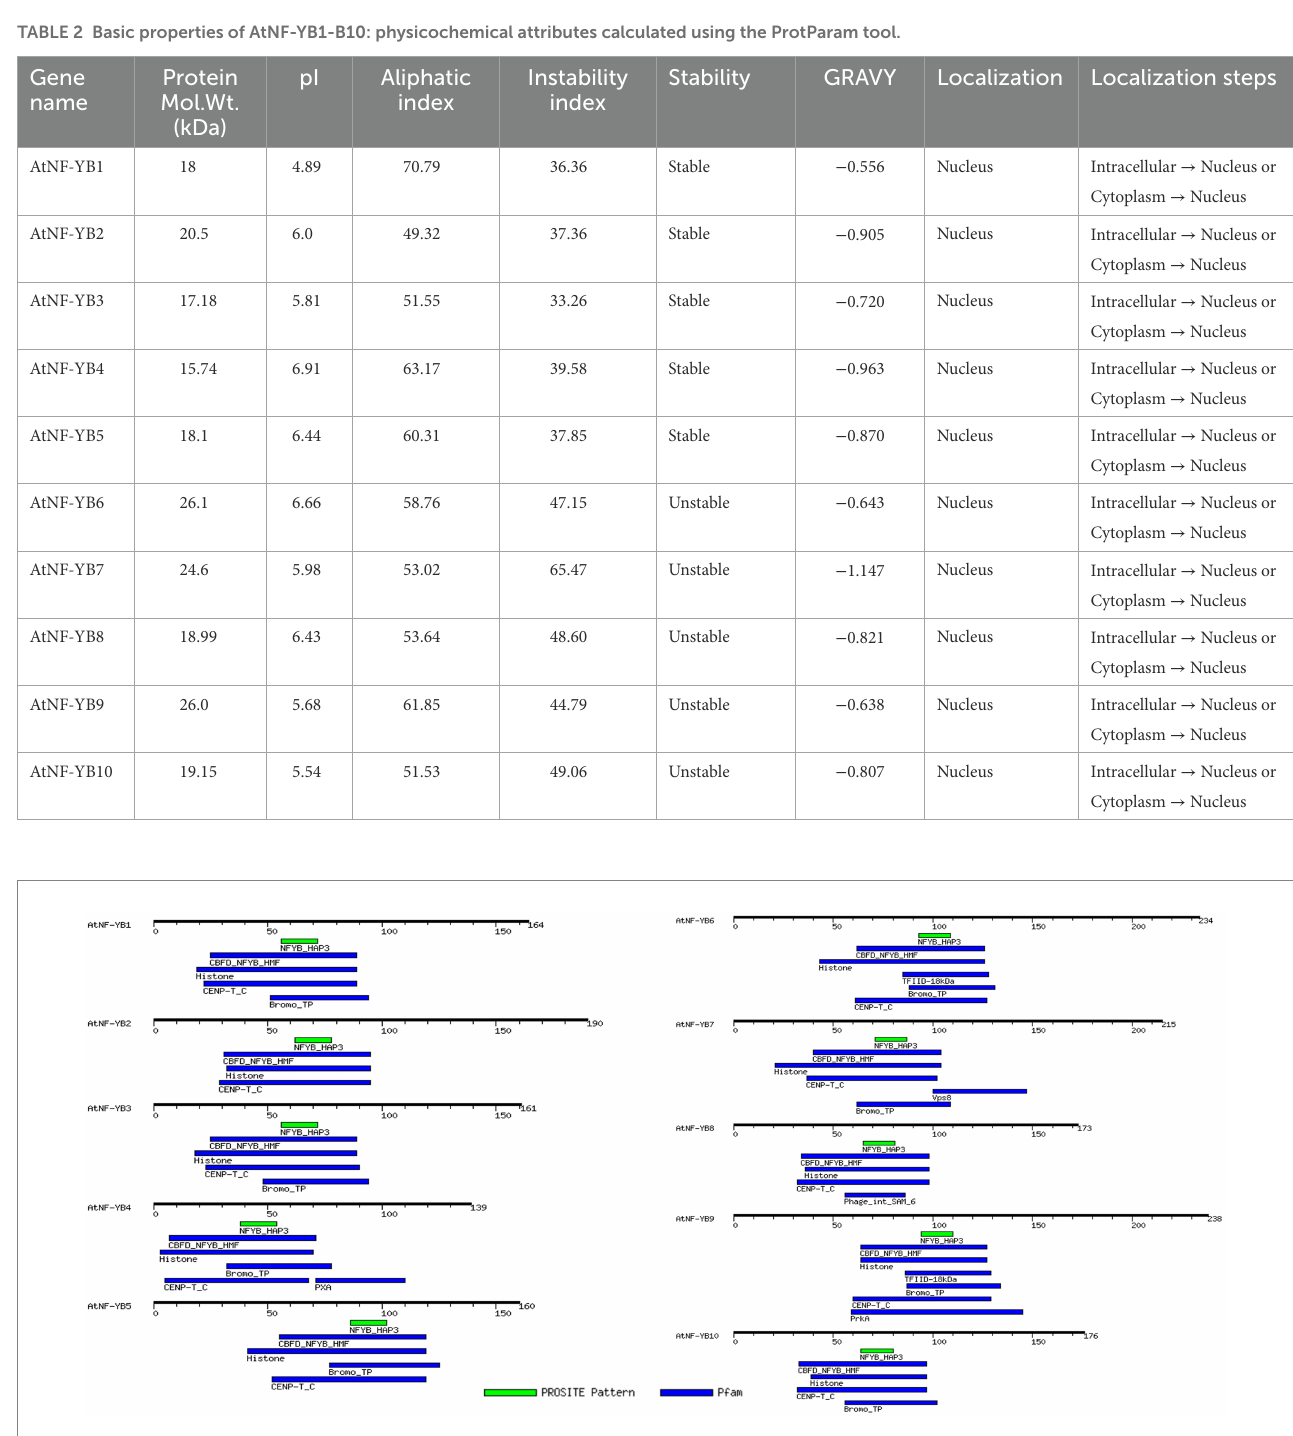
FIGURE 2 MotifFinder tool, used for identification of motifs on each AtNF-YB gene. Colour coded motif symbol represents the motifs of the highest density and prevalence. Default parameters of E-value at 1.0, and utilisation of Pfam and PROSITE databases were used and used for analysis and visualisation.